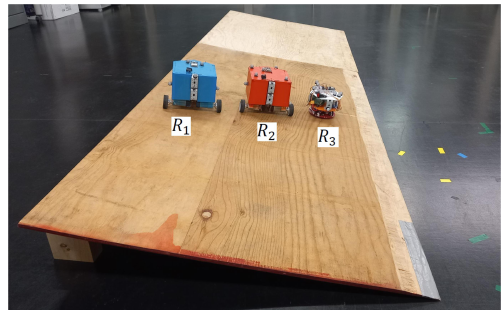
Figure 9. Uneven surface as a disturbance experimental